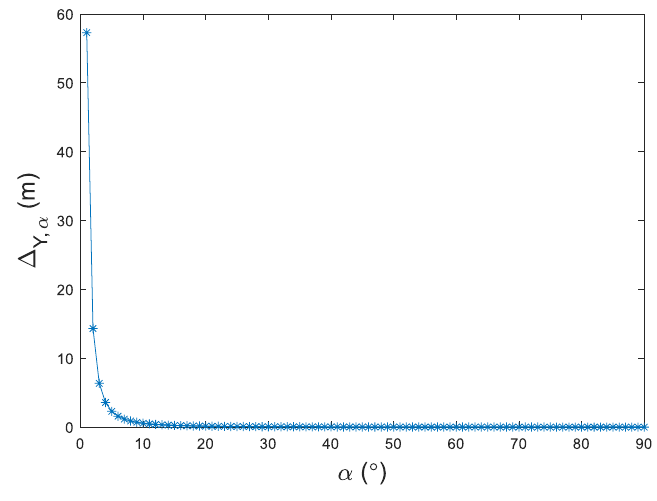
Figure 8. vs. azimuth  Figure 8. ∆ Y , α vs. azimuth α .